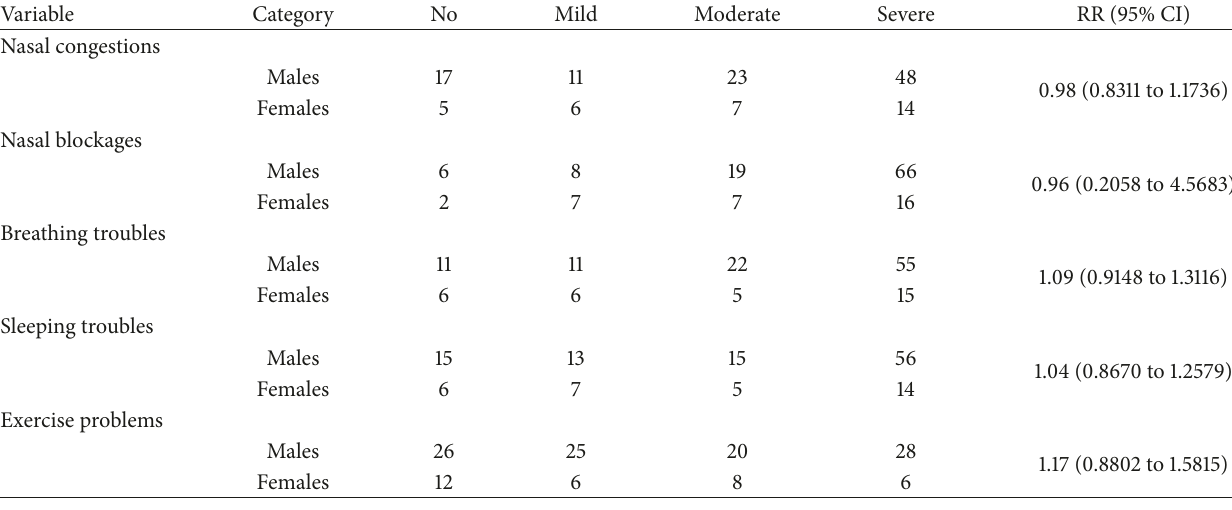
Table 3: Distribution of the study subjects by gender and clinical presentations.